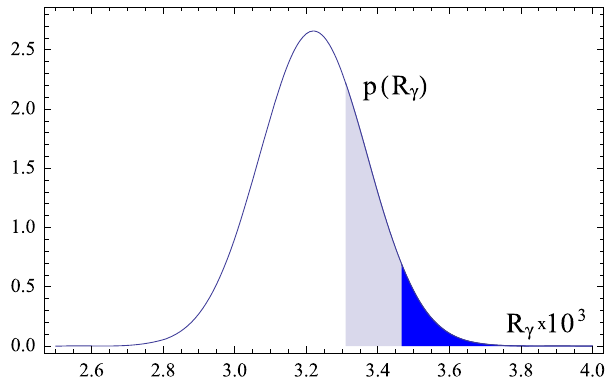
Fig. 3 Left Probability density for R exp γ = ( 3 . 22 ± 0 . 15 ) × 10 − 3 , assuming a Gaussian distribution. The integrated probability over the dark-shaded region amounts to 5%. In the absence of theoretical uncer- tainties, the light-shaded region is accessible in Model II only for